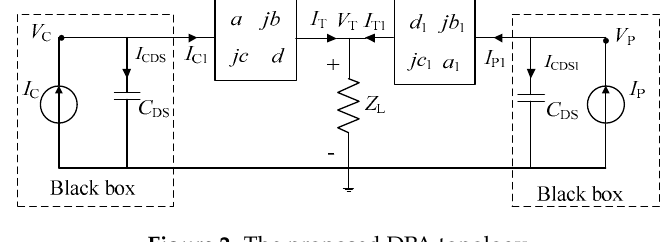
Figure 2. The proposed DPA topology.